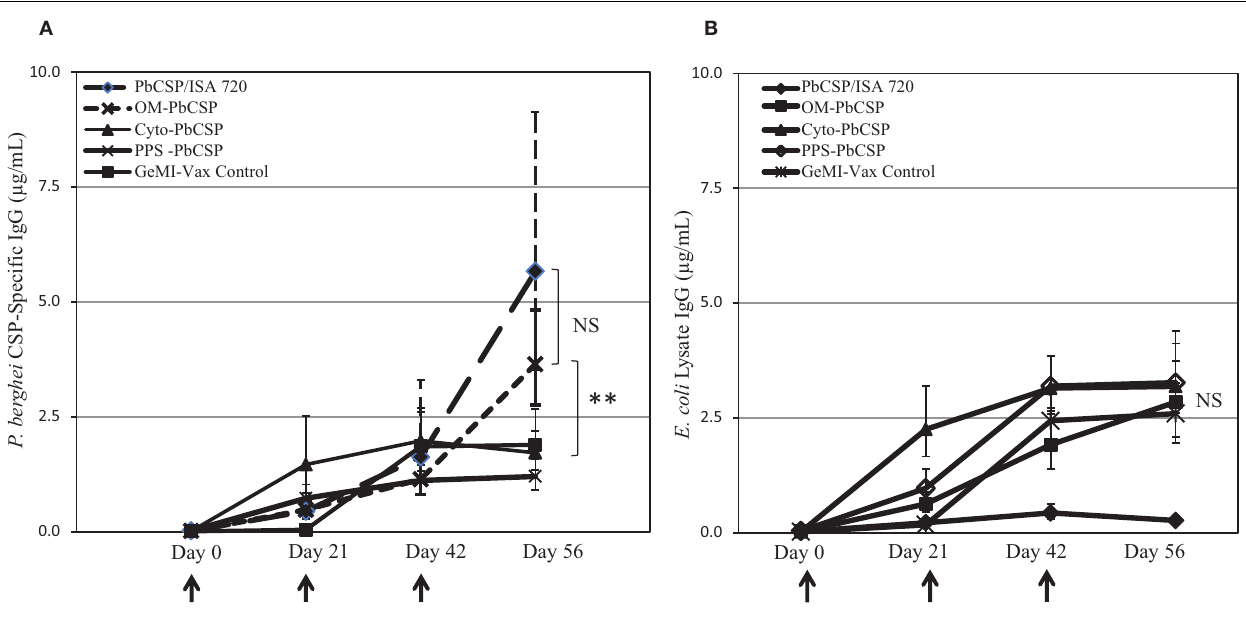
FIGURE 4 | OM- Pb CSP GeMI-Vax bacteria induce strong humoral immune responses . Sera from mice immunized with either OM- Pb CSP, PPS- Pb CSP, Cyto- Pb CSP, or recombinant Pb CSP adjuvanted with Montanide ISA-720 were collected two days prior to each immunization and tested for reactivity against r Pb CSP (A) or on E. coli lysates (B) .